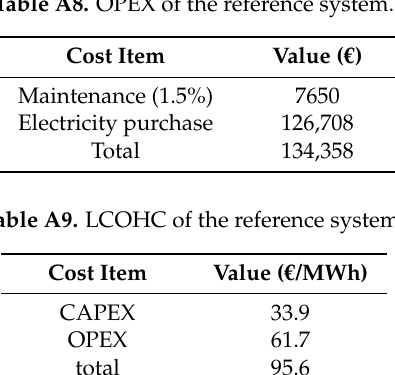
Table A8. OPEX of the reference system.